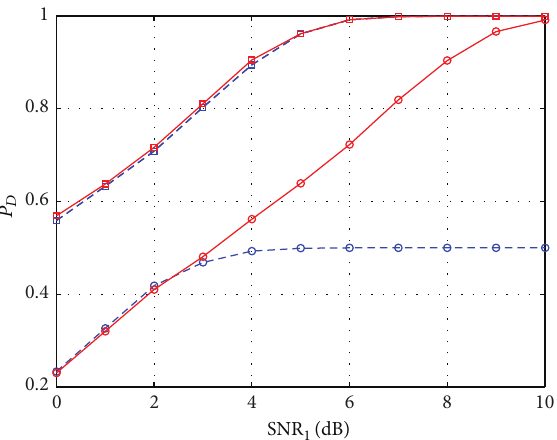
Figure 3: 𝑃 𝐷 versus SNR for SequOMP detector (blue dashed line) and Sup-GLRT detector (red solid line), in the case of two scatterers of different amplitude with 3 dB SNR difference (SNR 1 = SNR 2 + 3 dB) and at a separation distance 𝐷 𝑠 = 2𝜌 𝑠 , with 𝑃 (circle markers), and 𝑀 = 25 (square markers).